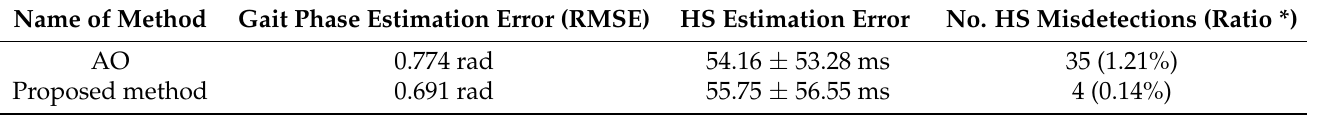
Table 1. Estimation performance when participants walked without knee restriction.